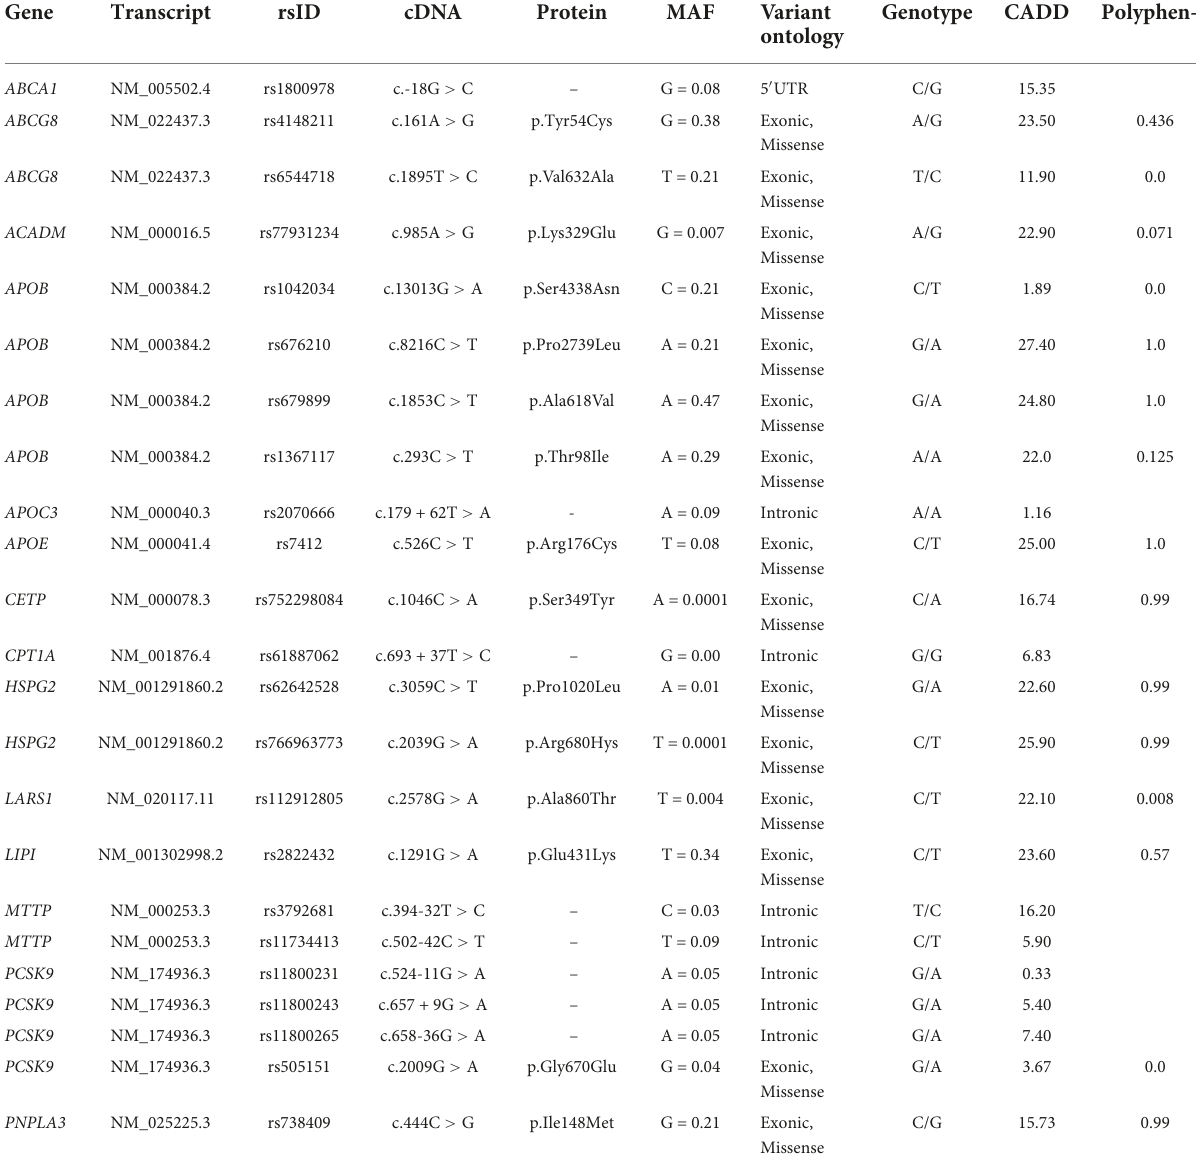
TABLE 2 Possibly pathogenic rare and common variants involved in hypertriglyceridemia development, identified in the 40-year-old woman with